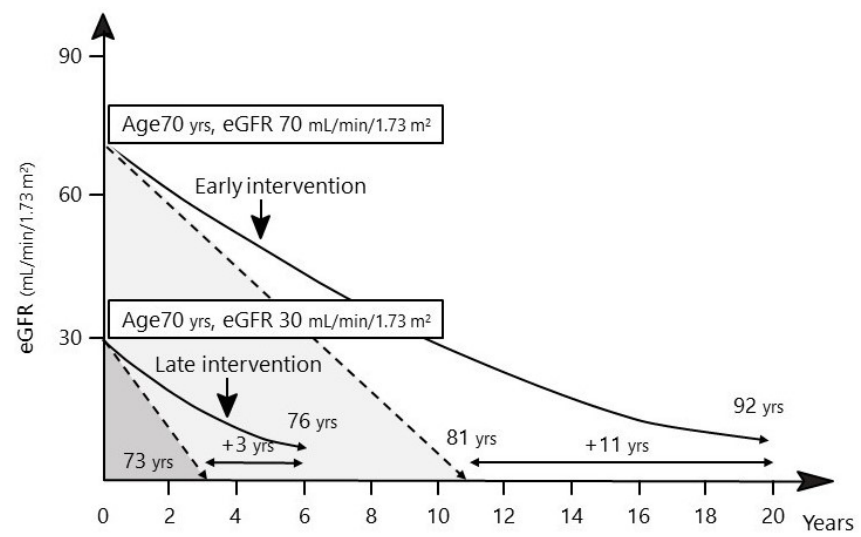
Figure 1. Importance of an early diagnosis and therapeutic intervention in patients with DKD.